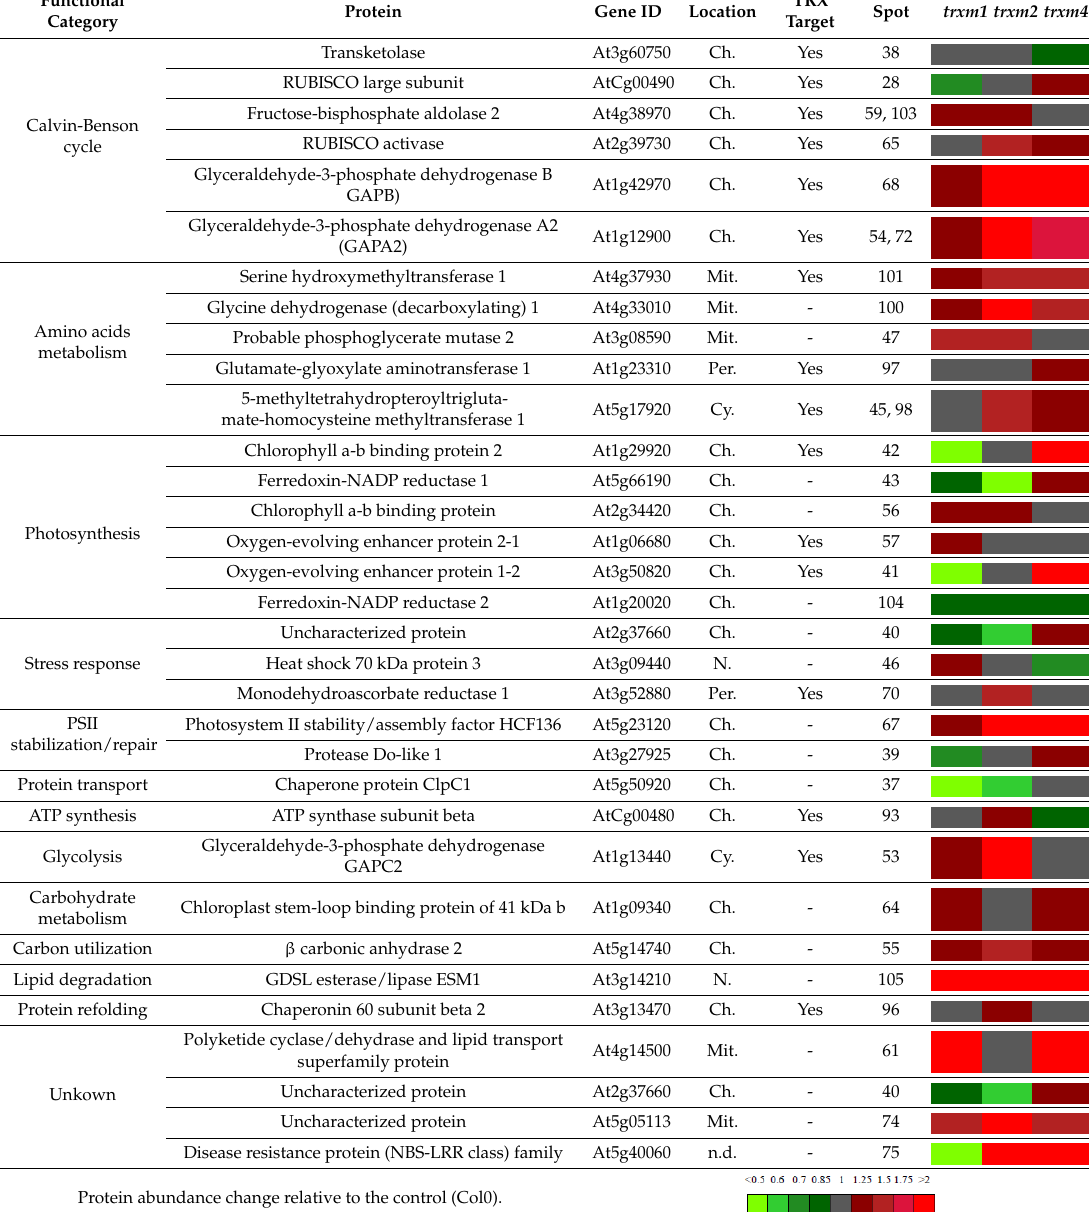
Table 2. Differentially expressed proteins identified by MS in the trxm1 , trxm2 , and trxm4 mutants, organized in the functional category, the gene code and the subcellular localization and whether the protein has been reported as a TRX target. The color code indicates fold change in protein abundance.